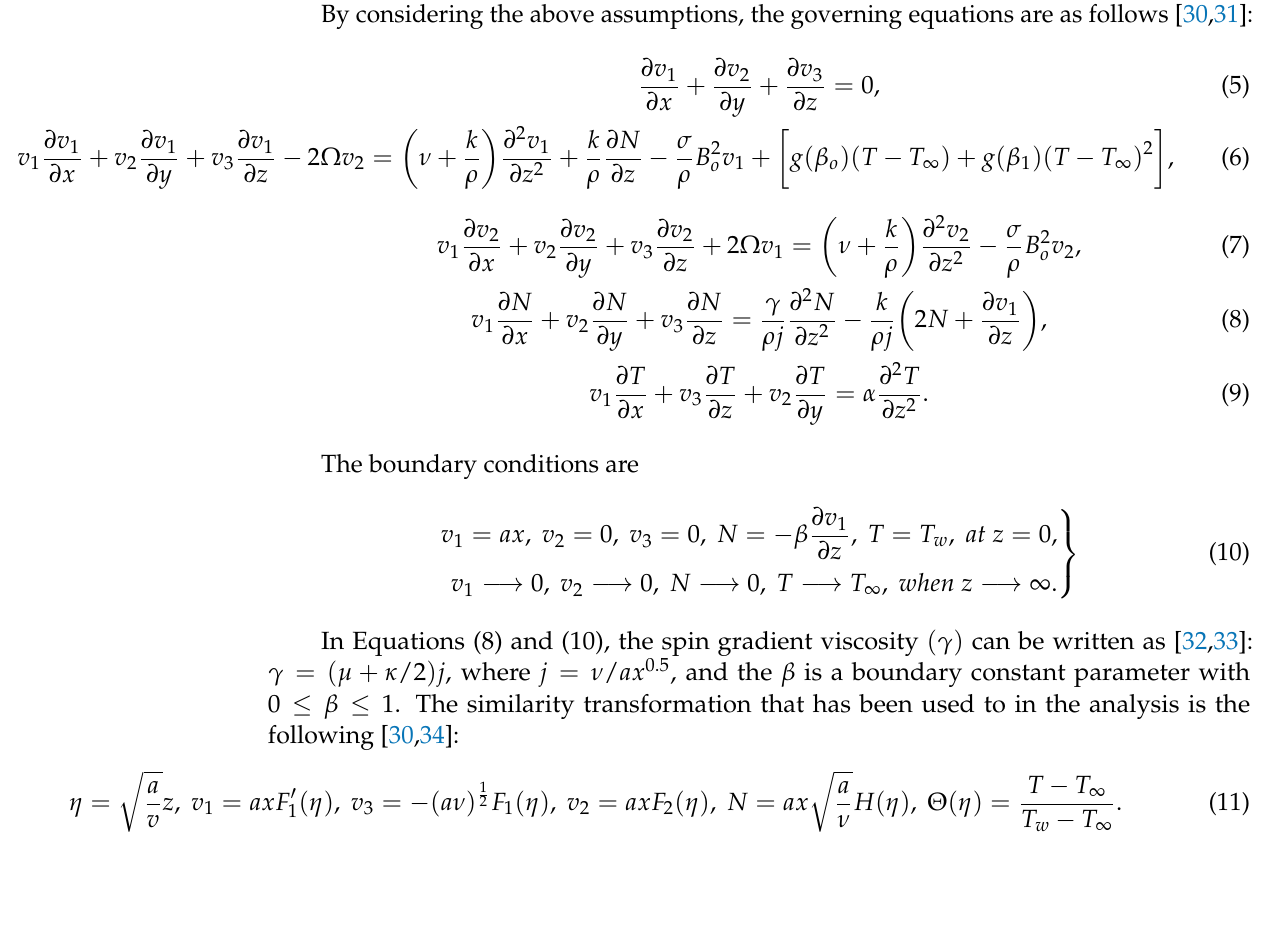
Figure 1. The flow geometry representing the dynamics of rotating micropolar fluid over a stretched